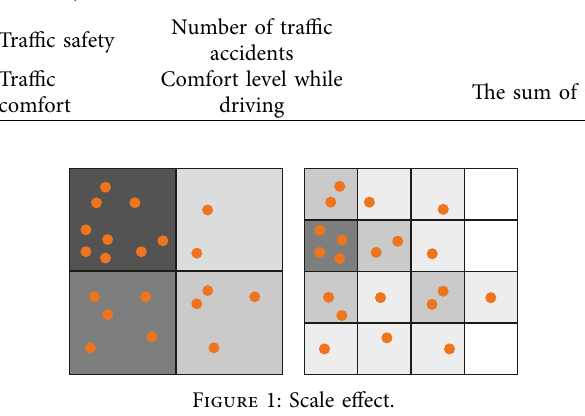
Figure 1: Scale effect.